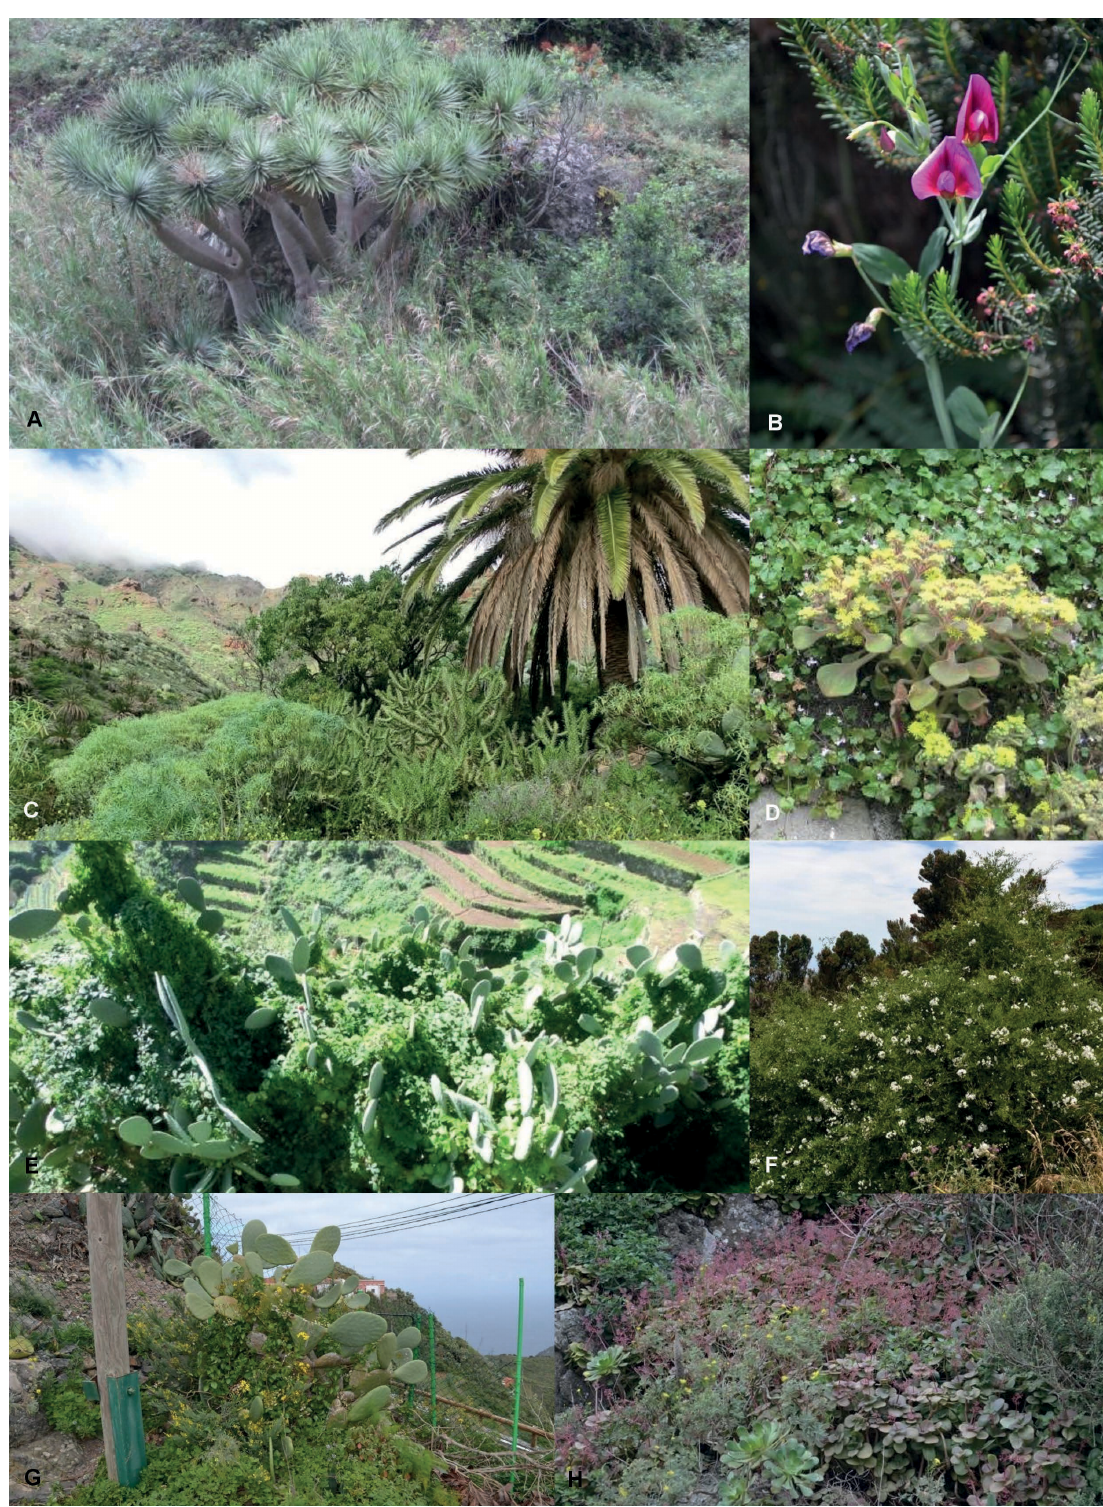
Figure 8 – Exotic invaders and endemic species in Anaga Rural Park. A, Dracaena draco in an area invaded by Arundo donax ; B, Lathyrus tingitanus together with Erica platycodon ; C, Austrocylindropuntia subulata growing together with the endemic species Euphorbia lamarckii and Phoenix canariensis ; D, Cymbalaria muralis introduced with ornamental intentions, coexisting with the Canarian endemic Aichryson laxum ; E, several invaders apparently competing amongst each other: Boussingaultia cordifolia , Ipomoea cairica and Opuntia ficus - indica ; F, Solanum laxum in the habitat of Erica platycodon , a Canarian endemic; G, invasion of Senecio angulatus , an exotic liana, in interspecific coexistence with Opuntia ficus-indica , another exotic alien; H, Crassula multicava at a roadside location as dominant